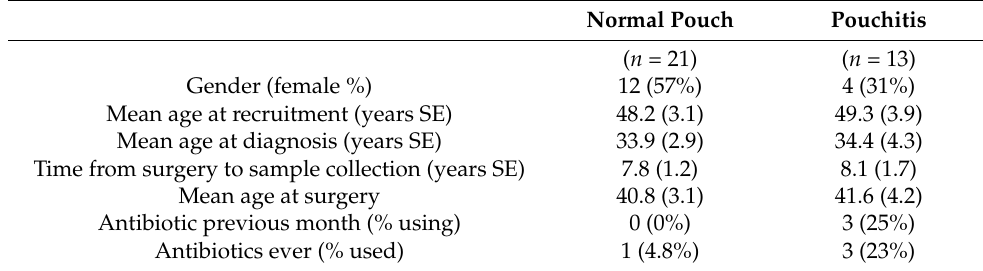
Table 1. General characteristics of the IPAA UC